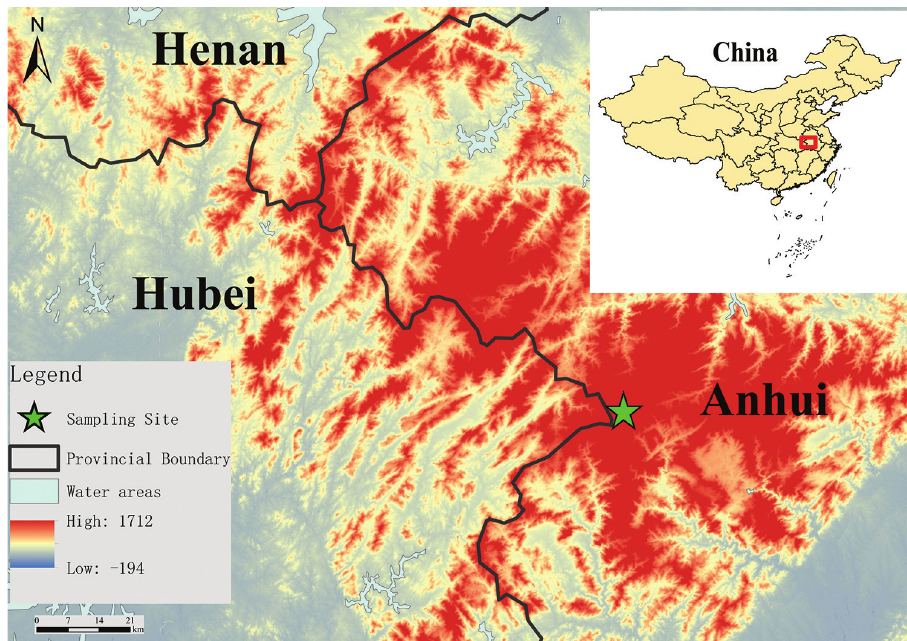
Figure 1. Distribution of Rana dabieshanensis sp. n. in Dabie Mountains (Anhui, Hubei, and Henan provinces, central China). Occurrence record is marked with green mark. Table 1. Primers used for PCR and